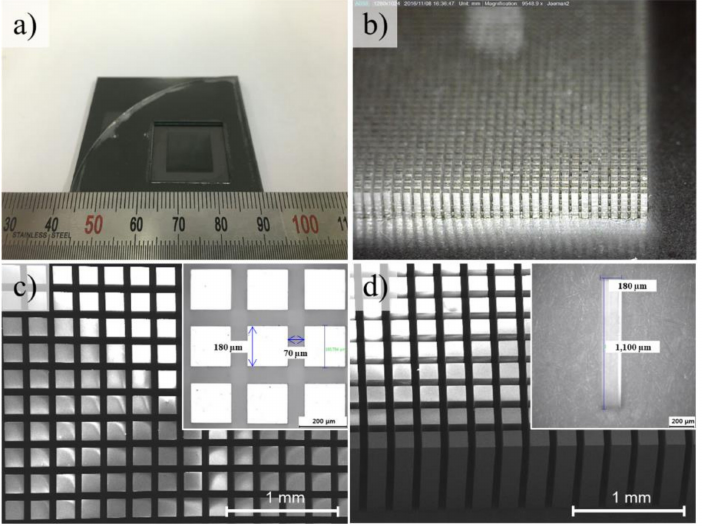
Figure 3. A defect-free mother structure for electroforming. ( a ) Entire image of mother structure; ( b ) magnified view; ( c ) top view; ( d ) side